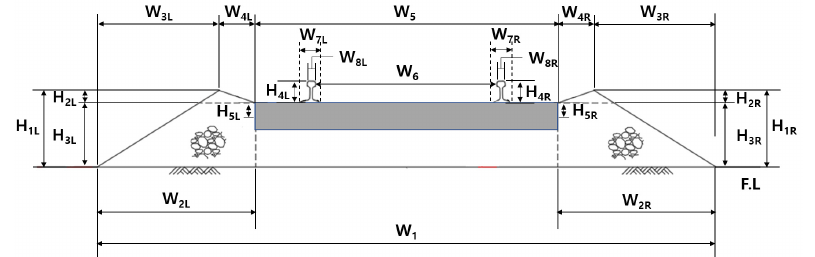
Figure 4. Cross-sectional diagram of representative parameters for ballasted track.